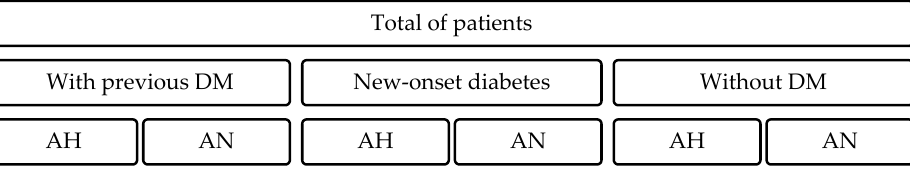
Figure 1. Groups considered for the analysis. Abbreviations: (AH, At-admission hyperglycemia; AN, At-admission normoglycemia; DM, Diabetes mellitus ).